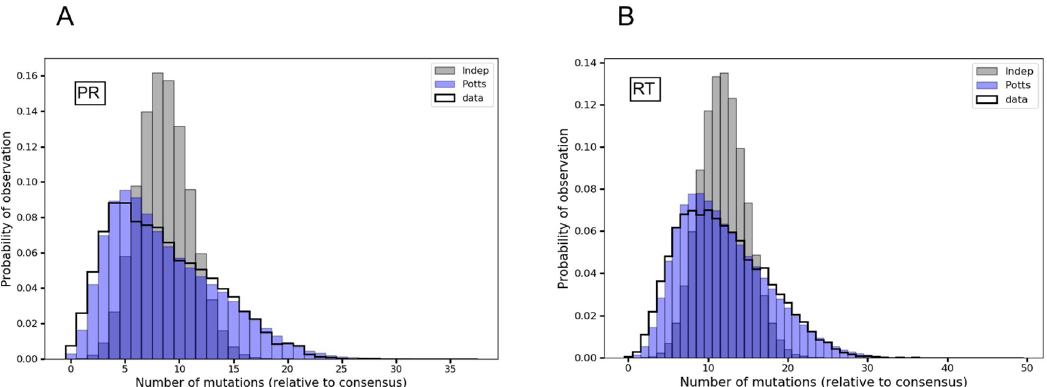
Fig 2. Distribution of the number of mutations (hamming distances) in drug-experienced HIV-1 sequences as captured by the Potts and independent models. Probabilities of observing sequences with any k number of mutations relative to the HIV-1 subtype B wild-type consensus sequence as observed in original MSA (black) and predicted by the Potts (blue) and independent (gray) models are shown for HIV-1 protease (PR) in (A), and reverse transcriptase (RT) in (B), respectively. The independent model predicted distribution does not accurately capture the distribution of hamming distances in the dataset MSA, especially near the ends of the distribution with either very low or very high number of mutations, where the epistatic effects can be more